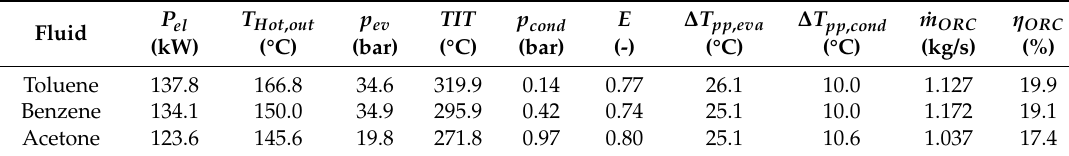
Table 8. Most promising pure fluids using ICE measured